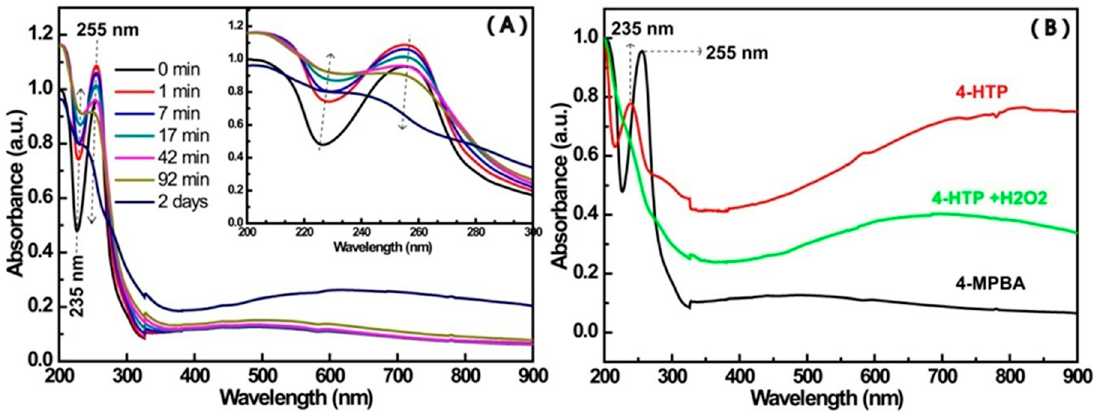
Figure 9. The change in the UV-Vis spectrum with time for di ff erent samples. ( A ) The change in the spectrum of Mixt.3 (0.15 mM MPBA, 0.012% H 2 O 2 ) with time (inset: the spectra ranging from 200 nm to 300 nm); ( B ) 4-MPBA aqueous solution (black), 4-HTP aqueous solution (red), Mixt.5 (0.07 mM 4-HTP, 0.012% H 2 O 2 ) after 20 min reaction (green).